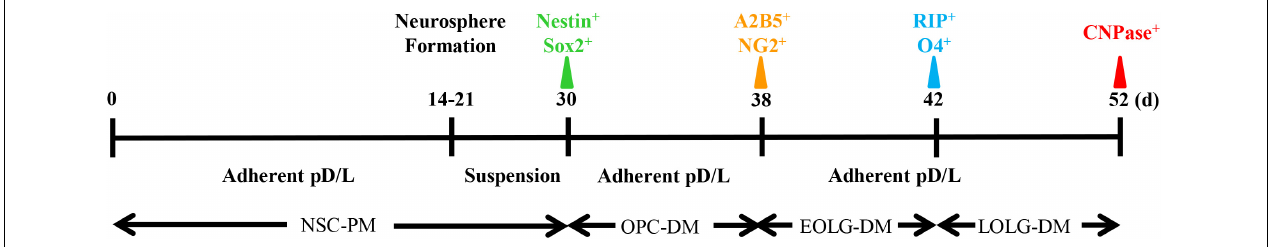
FIGURE 2 | Generation of bone marrow-derived NSCs in vitro . BM-NSCs were isolated and expanded from bone marrow of adult C57BL/6 mice and cultured in DMEM/F12 containing 20 ng/ml EGF, 20 ng/ml Bfgf, and 2% B27 supplements. (A) Single cells were seeded in poly-D-lysine- and laminin-coated plates. After 7 days, the cells showed obvious proliferation. After 14 days, the NSCs gradually formed neurospheres. After 21–28 days, neurospheres increased size, and detached from the bottom of the culture plate. (B) Growth curves of BM-NSCs and SVZ-NSCs. Single cells at the second and fifth passages were seeded at a density of 1.0 × 10 5 cells/ml and cultured in proliferation media. At days 6, 11, 16 and 21, neurospheres in each well were digested into single cells; cell numbers were counted by hemocytometer. At least 5 wells were evaluated at each time point. Data represent the mean ± SD from three repeated experiments from separately generated cultures, ∗ p < 0.05, ∗∗ p < 0.01, as determined by two-way ANOVA with Tukey’s multiple comparison test. (C) Neurospheres dissociated with accutase and plated in the coated coverslips were immunostained for NSC markers Sox2 and Nestin. Scale bar = 50 µ m.